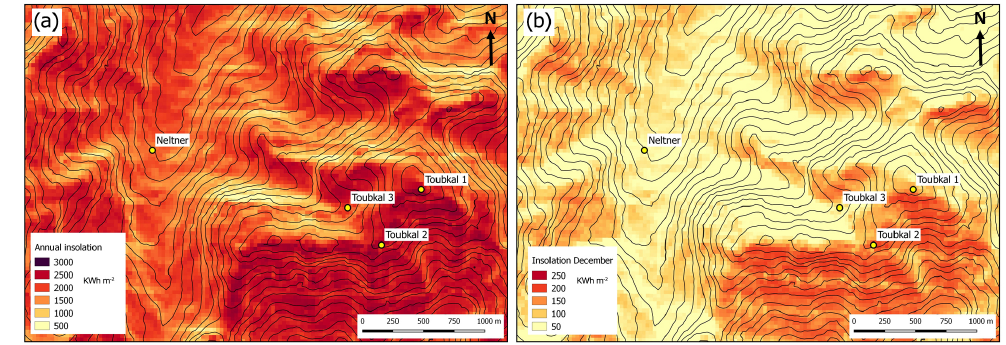
Figure 9. Modelled distribution of potential annual (a) and December (b) solar radiation in the Toubkal massif, with the locations of the ground surface temperature monitoring sites (yellow dots). Note that the colour bars are different.